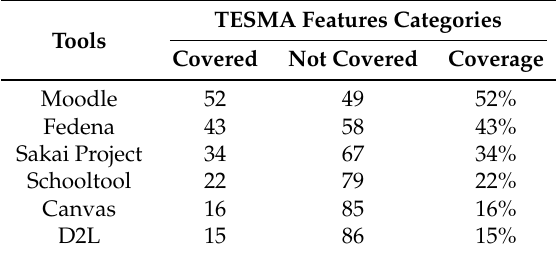
Table 1. The six most interesting tools resulting from our study and their coverage w.r.t. the TESMA features